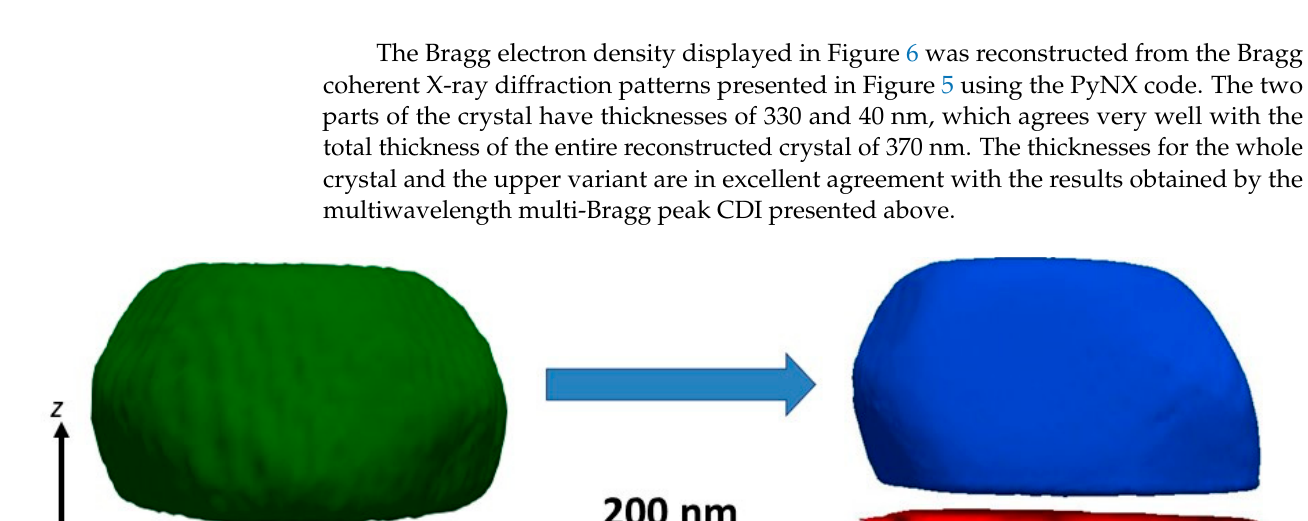
Figure 5. Bragg coherent X-ray diffraction patterns of the Au 111, Au 200, and Au 002 Bragg reflections for a twinned Au crystal where the twin boundary is parallel to the crystal–substrate interface.